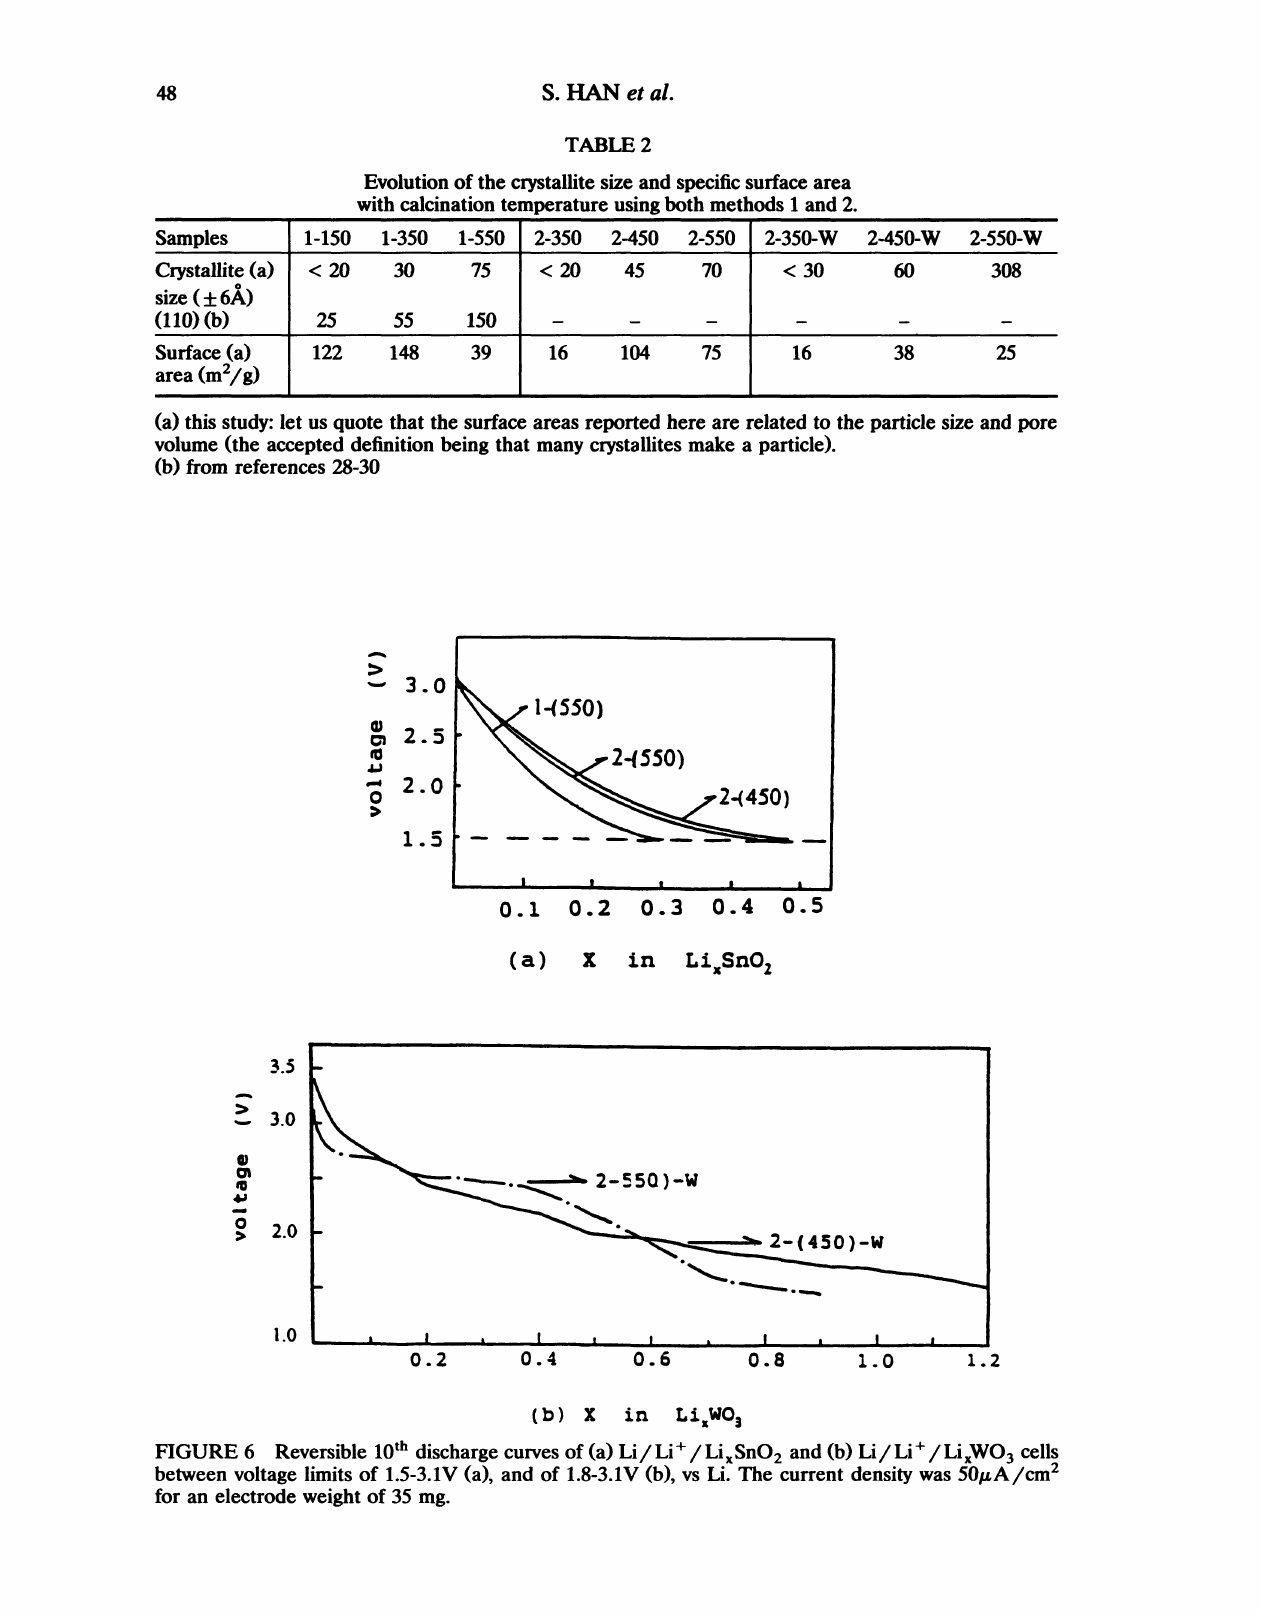
FIGURE 6 Reversible 10 th discharge curves of (a) Li/Li +/LixSnO between voltage limits of 1.5-3.1V (a), and of 1.8-3.1V (b), vs Li. The current density was 50/tA/cm 2 for an electrode weight of 35